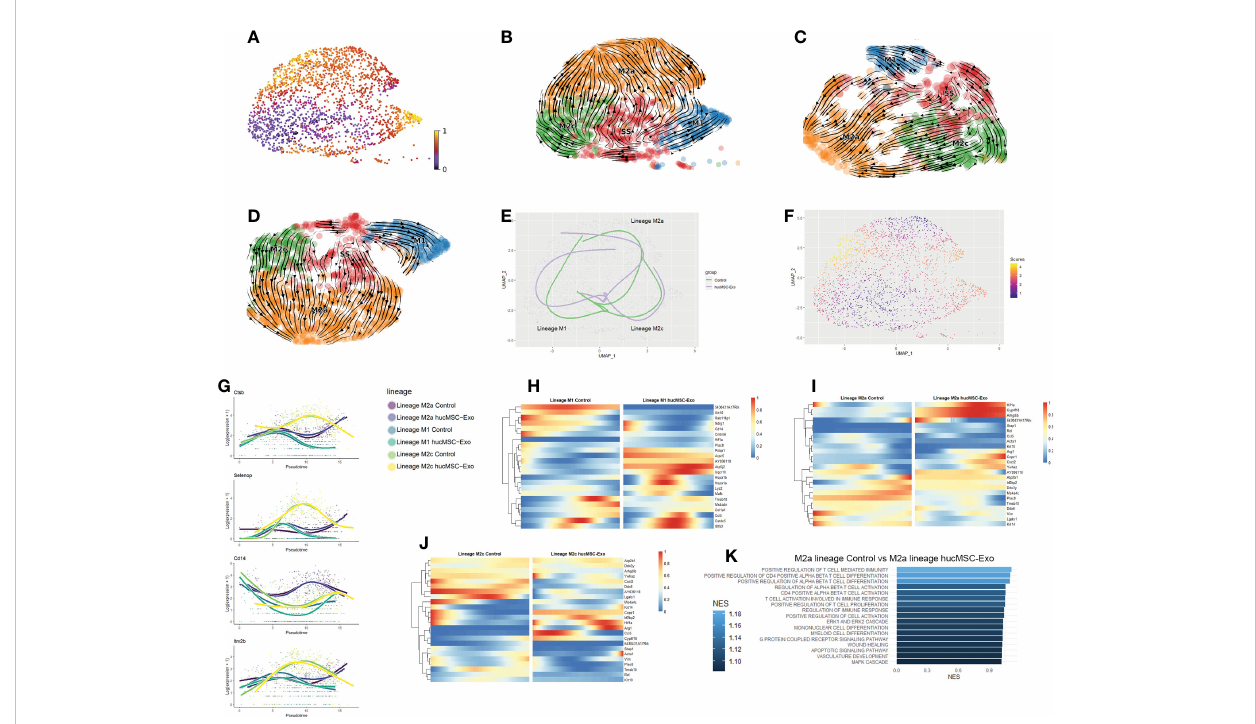
FIGURE 5 Pseudotime and RNA velocity pro fi les of macrophages (A) Latent time graph based on UMAP reduction of M1 and M2 macrophages; cells are colored based on latent time. (B) Scatterplot of macrophages RNA velocity graph. (C) Scatterplot of macrophages RNA velocity graph for the control group. (D) Scatterplot of macrophages RNA velocity graph for the hucMSC-Exosomes group. (E) Scatter and trajectory plot based on UMAP reduction of macrophages. (F) Scatterplot for imbalance score for macrophages. Bright yellow regions indicate that nearby cells share the same condition. Deep blue regions mean that nearby cells are from a mix of the hucMSC-Exosomes group and the control group. (G) Smoother plot of gene expression along trajectories for macrophages. (H) Heatmap of gene ’ s differential expression between conditions along the M1 trajectory. (I) Heatmap of gene ’ s differential expression between conditions along the M2a trajectory. (J) Heatmap of gene ’ s differential expression between conditions along the M2c trajectory. (K) Barplot of the hucMSC-Exosomes groups vs the control group GSEA biological pathways that are signi fi cantly (P value <0.05) elevated from differentially expressed genesalong the M2a